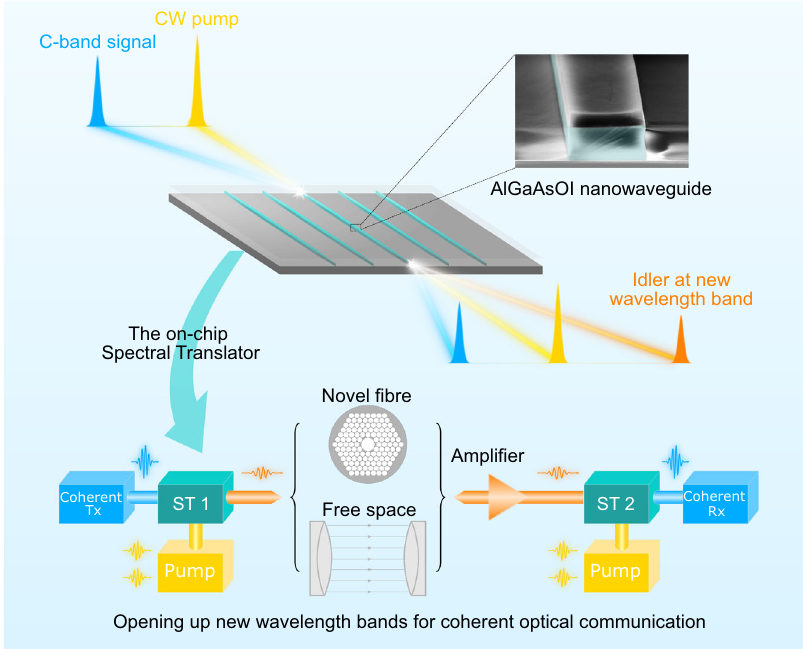
Fig. 1 Opening up new wavelength bands for coherent optical communication through on-chip continuous spectral translation. The spectral translators are based on continuous-wave (CW) pumped aluminium gallium arsenide on insulator (AlGaAsOI) nanowaveguides where a continuous conversion bandwidth over an octave can be achieved with reasonable conversion ef fi ciency. Using a pair of spectral translators (ST 1 and ST 2), an optical coherent transmitter and a receiver working at new wavelength bands can be realized with high-performance C-band counterparts. Such a spectral translator-based coherent optical communication scheme has the potential to utilize the vast unexploited wavelength bands possible in novel fi bres or free space without the need to develop optical transceivers at those wavelength